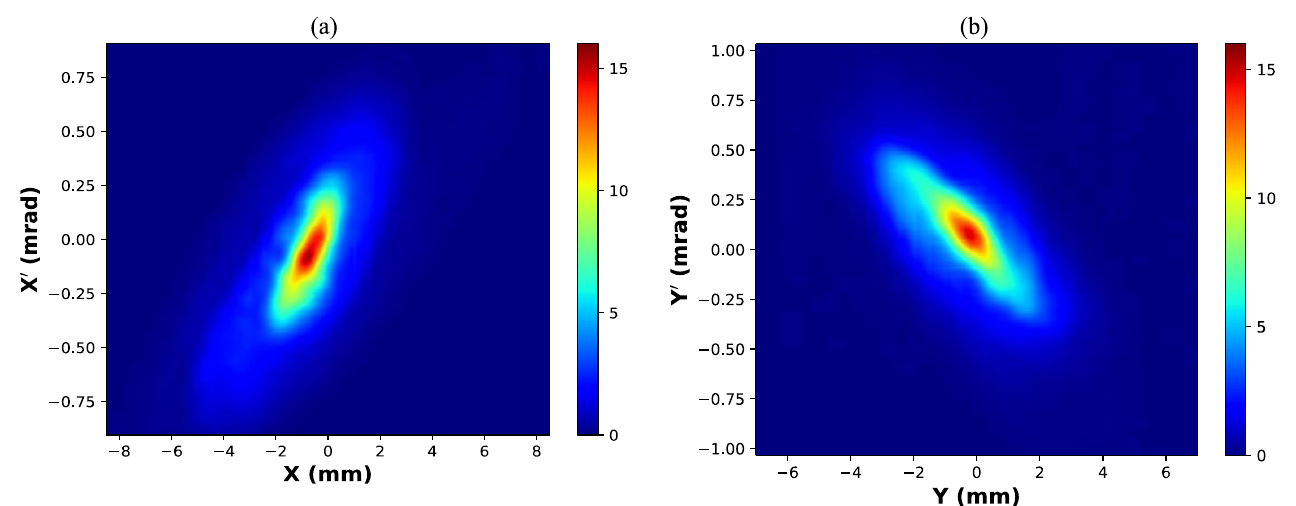
FIG. 9. Measured phase space distributions in horizontal (a) and vertical (b) planes from one laser comb tooth. Viewing from upstream, horizontal scan is conducted from left ( − ) to right ( þ ) and vertical scan is conducted from bottom ( − ) to top ( þ ) in all emittance